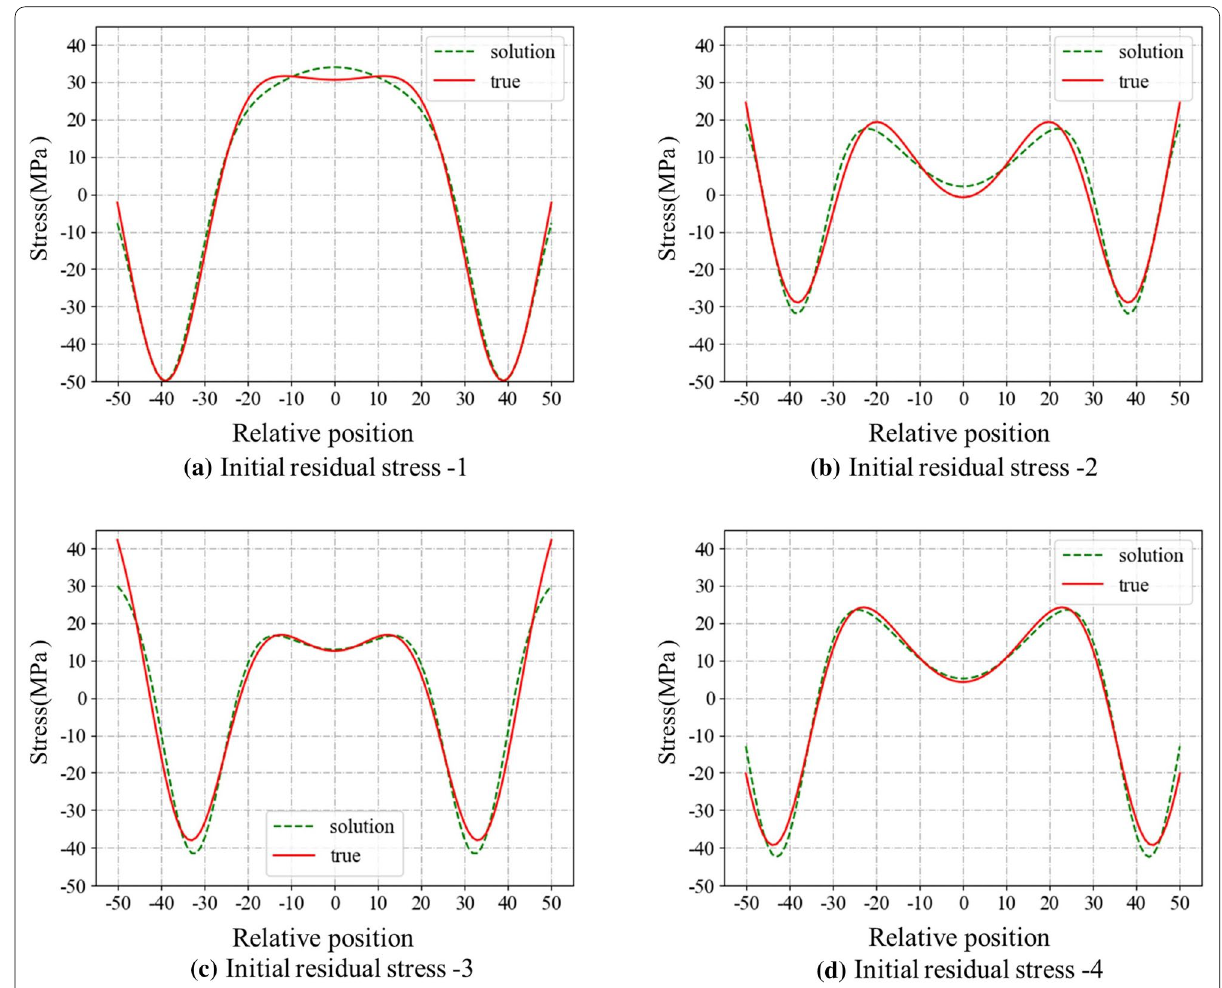
Figure 10 The inferred initial residual stress and compared with ground